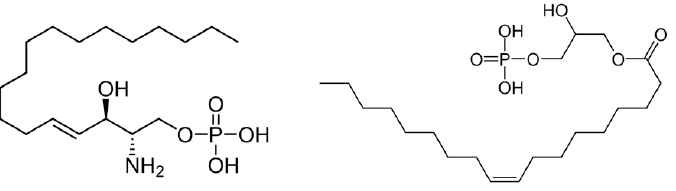
Figure 1. Structures of sphingosine-1-phosphate ( left ) and lysophosphatidic acid ( right ). Olfactory ensheathing cells (OECs), which are a specialized glial cell population with axonal growth-promoting properties in the olfactory system, express multiple S1P recep- tor transcripts, and are stimulated to proliferate in the presence of S1P. The proliferative